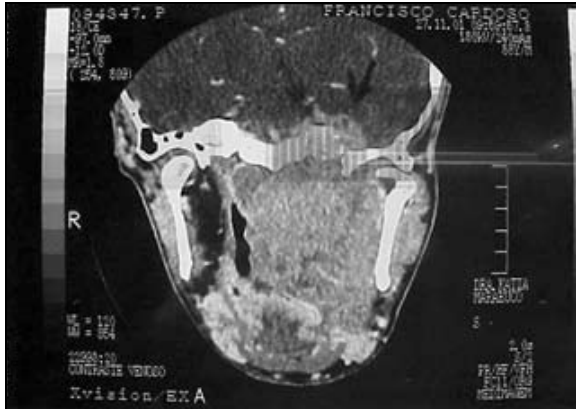
Figura 3 – Tomografia